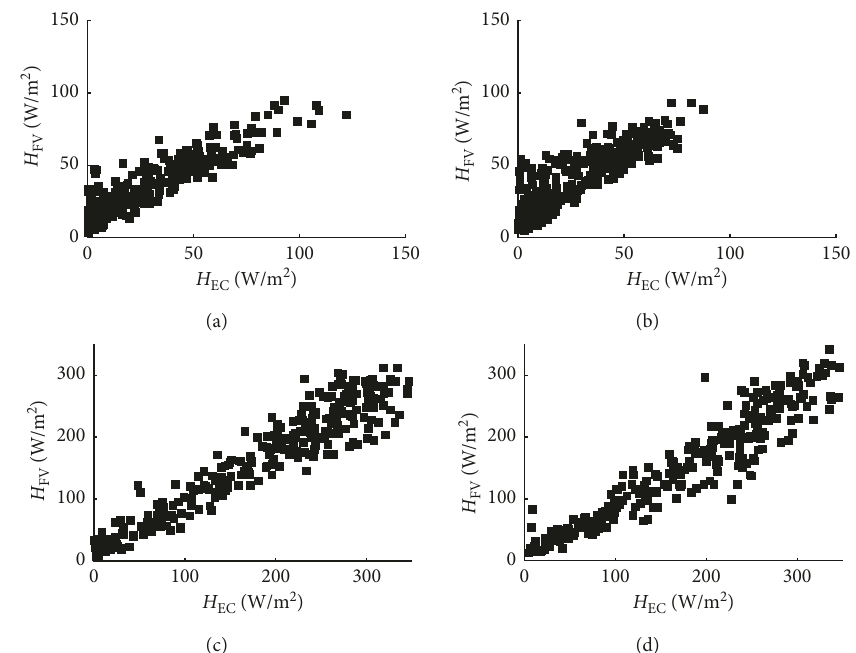
Figure 5: Sensible heat flux measured by EC versus that estimated by FV for calibration and validation during the two campaigns. FV data are calculated based on the temperature signal of the ultrasonic anemometer. S1 banana screenhouse: (a) calibration; (b) validation. S2 pepper screenhouse (above screen): (c) calibration; (d) validation.